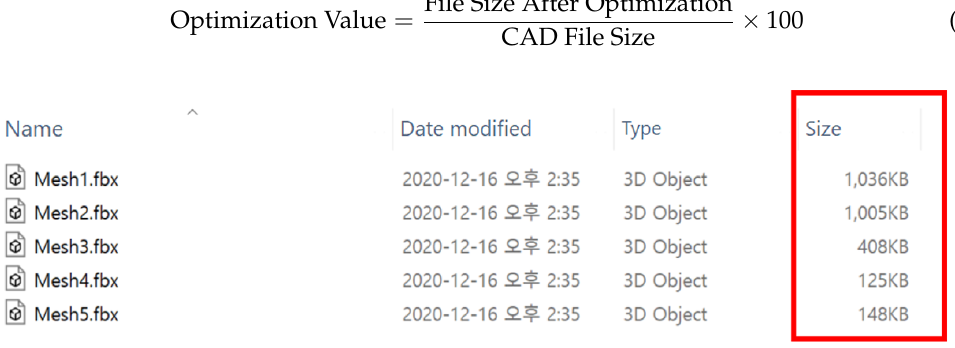
Figure 18. Data optimization